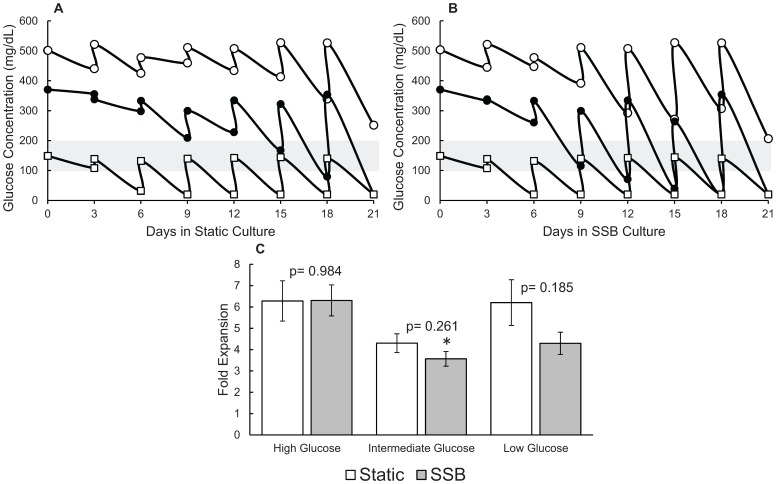
Fluctuations in medium nutrient levels contributed to limitations in cell expansion.Glucose measurements from β-TC6 cell spheroids cultured in (A) Static cultures, and (B) stirred suspension bioreactors using high (4.5 g/L), intermediate (2.75 g/L), and low (1.0 g/L) glucose medium, as depicted by their position on the Y axis. The physiological glucose range is indicated by the grey bar. Error bars for glucose measurements are too small to be visible on the scale shown (Standard Error ≤4% for all measurements). (C) No difference was seen comparing static to SSB cultures with any of the glucose levels. Comparison of expansion of β-TC6 spheroid cultures indicated that changing the glucose in the medium to achieve levels closer to the physiological range did not significantly improve cell expansion. (*indicates a p value of 0.027 compared with the same culture method using high glucose medium.) SSB: stirred suspension bioreactor.